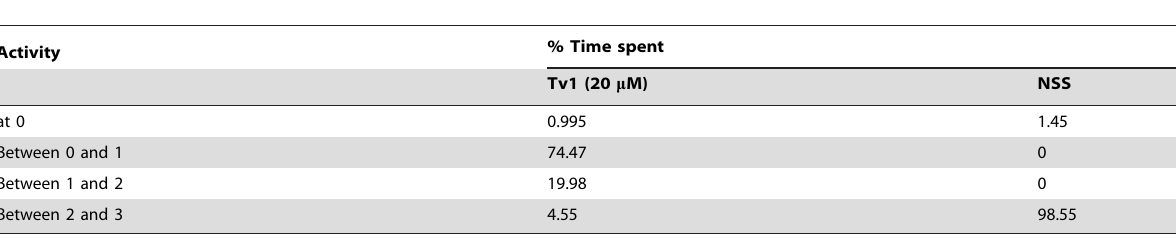
Table 2. Tv1 bioactivity in polychaete